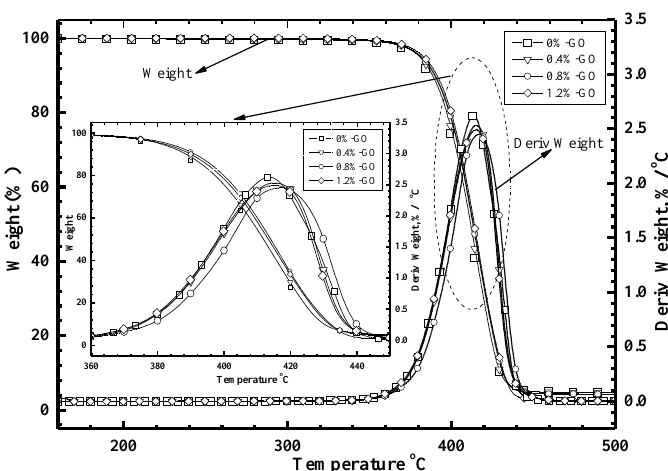
Figure 6. The TGA and DTG curves of neat epoxy resin and nanocomposite samples.